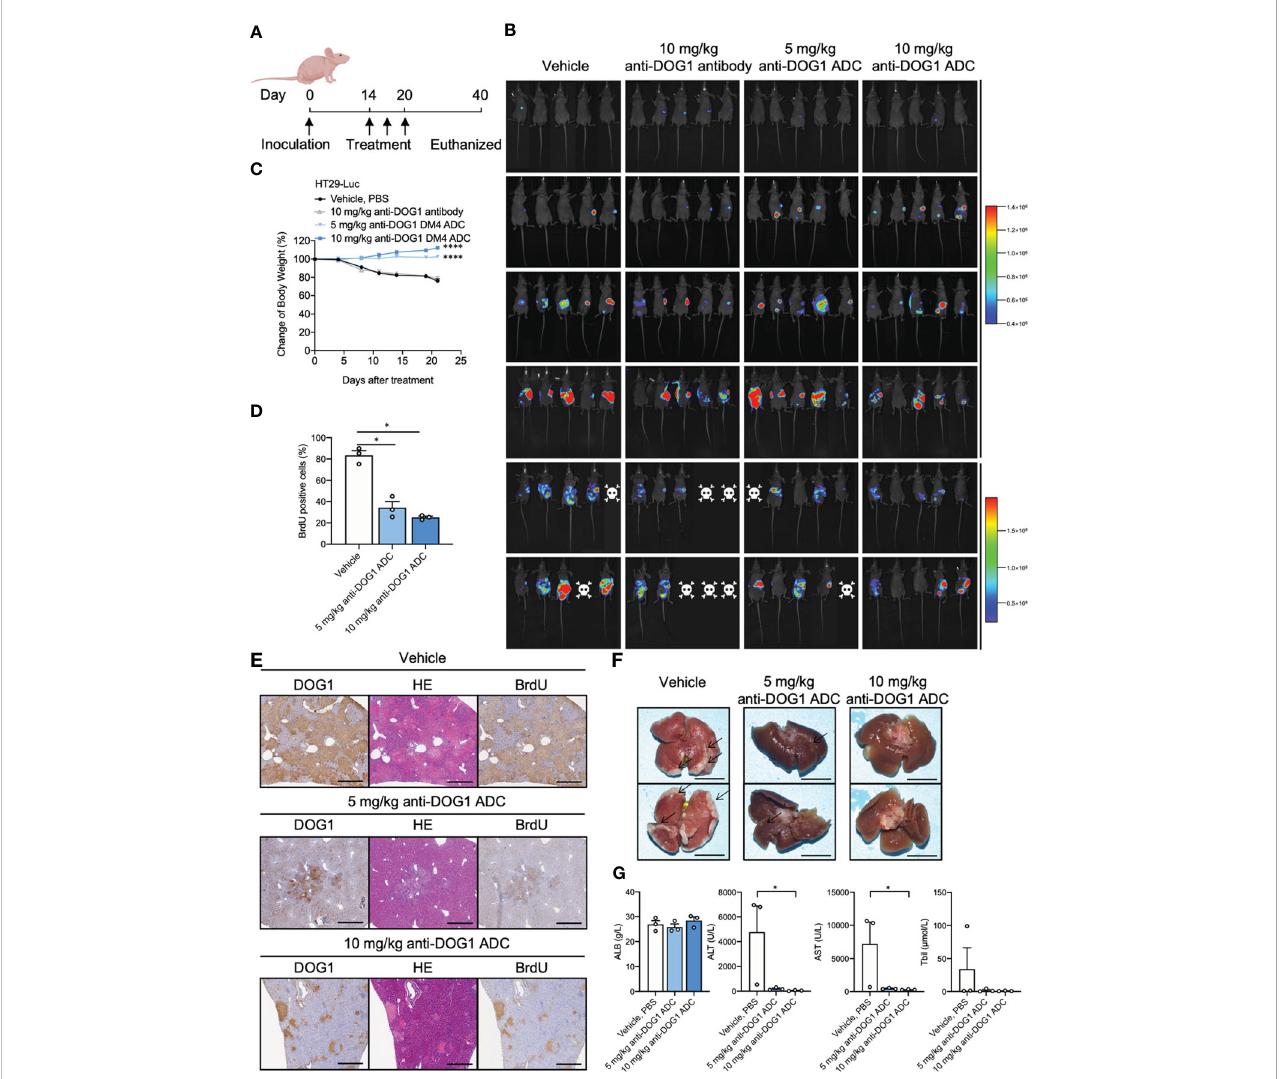
FIGURE 6 Anti-DOG1 antibody inhibited the experimental liver metastasis model of colon cancer. (A) Timeline of drug administration of the treated mice; (B) Bioluminescence on Day 1 to 35 post-HT-29-Luc cell injection; (C) The change in body weight during the experiment was calculated as the percent change in weight compared with the baseline measurement. Values are the mean ± SEM; n =5 mice per group; compared with the control group by one-way ANOVA; (D) BrdU positive rate of liver tissue on Day 35. Values are the mean ± SEM; n=3 mice per group; compared with the control group by one-way ANOVA; (E) DOG1, HE and BrdU IHC staining for liver tissue on Day 35; (F) Representative images of liver in the HT-29-Luc-bearing mice on Day 35; (G) The graph depicted ALB, ALT, AST Tbil on Day 40 after the inoculation. Values are the mean ± SEM; n=3 mice per group; compared with the control group by Friedman test or Kruskal-Wallis test. *P < 0.05; ****P